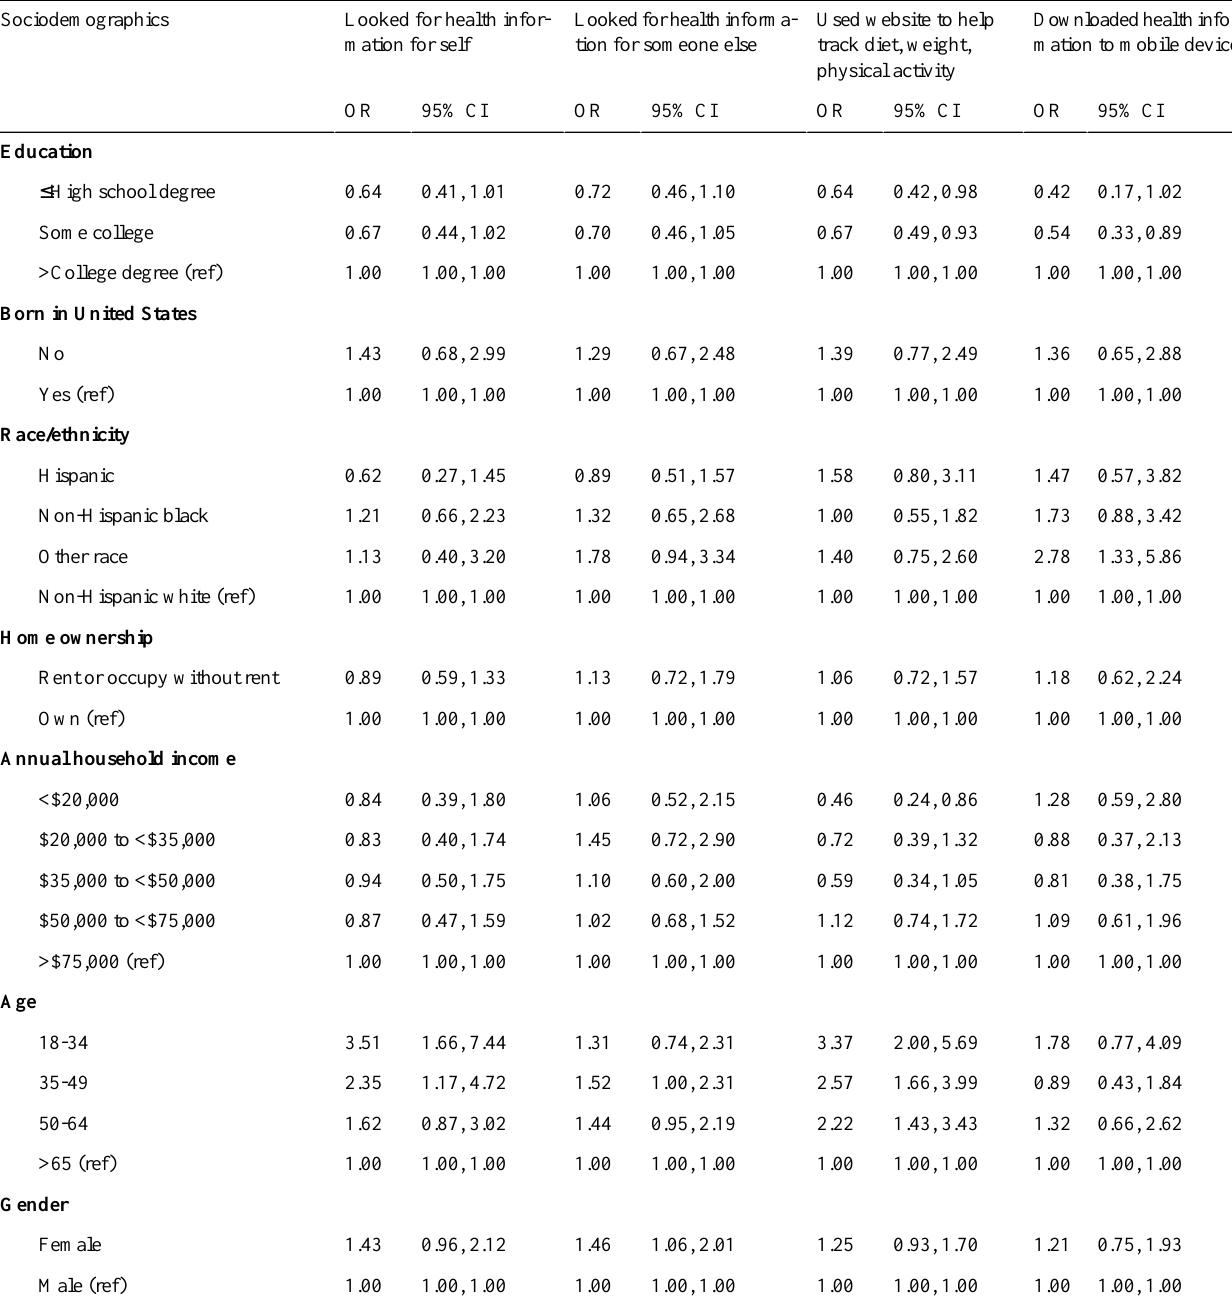
Table 4. Multivariable logistic regression models for odds a of reporting yes to eHealth usage, by socioeconomic status and race/ethnicity, Health Information National Trends Survey (HINTS), 2012.